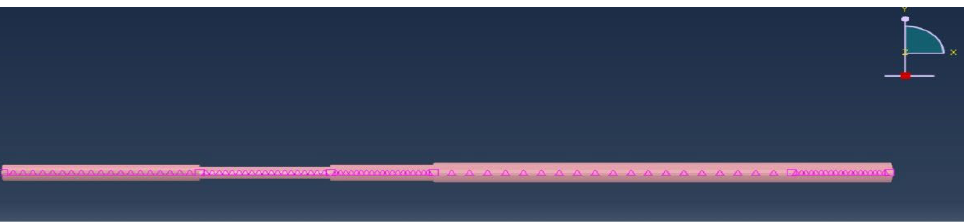
Figure 4. Schematic diagram of the new rotary steerable drilling system.